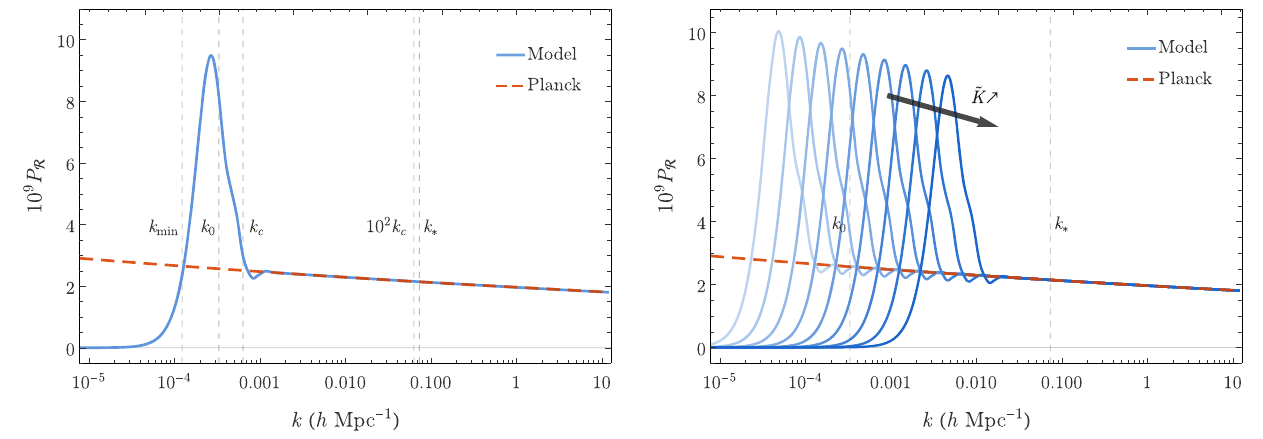
Fig. 4 (Left Panel) The characteristic power spectrum obtained for the model considered in Eq. (4.1). For k < k min the power spectrum is highly suppressed while for k (cid:13) k c the near scale-invariant shape is recovered. For modes in the range k min (cid:3) k (cid:3) k c two peaks of high amplitude appear. The position of these two peaks is related to the amplitude of the potential z (cid:10)(cid:10) / z in the two bumps visible in Fig. 1. For k (cid:2) 5 k c no imprints of pre-inflationary effects are observed on P R ,